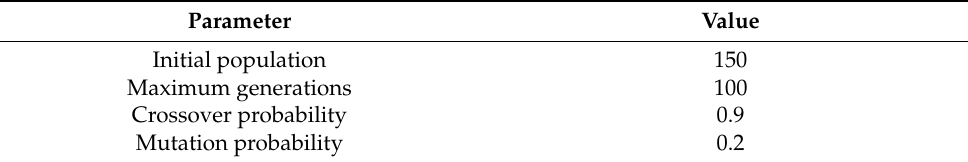
Table 5. Parameters of